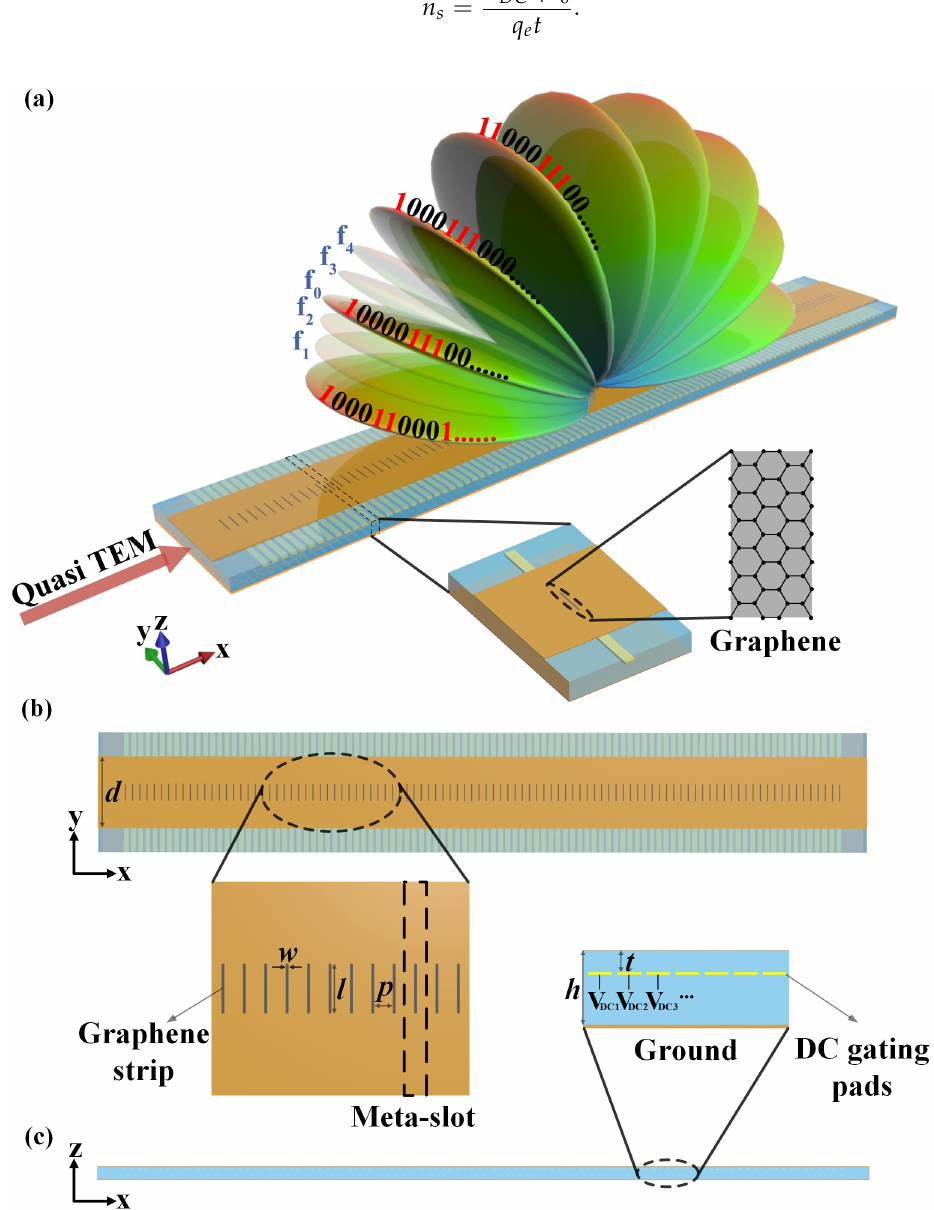
Figure 1. Schematic view of the graphene-biased terahertz coding meta-surface for the synthesis of scanning beams. ( a ) Full view. ( b ) Top view. ( c ) Cross-sectional view along the x